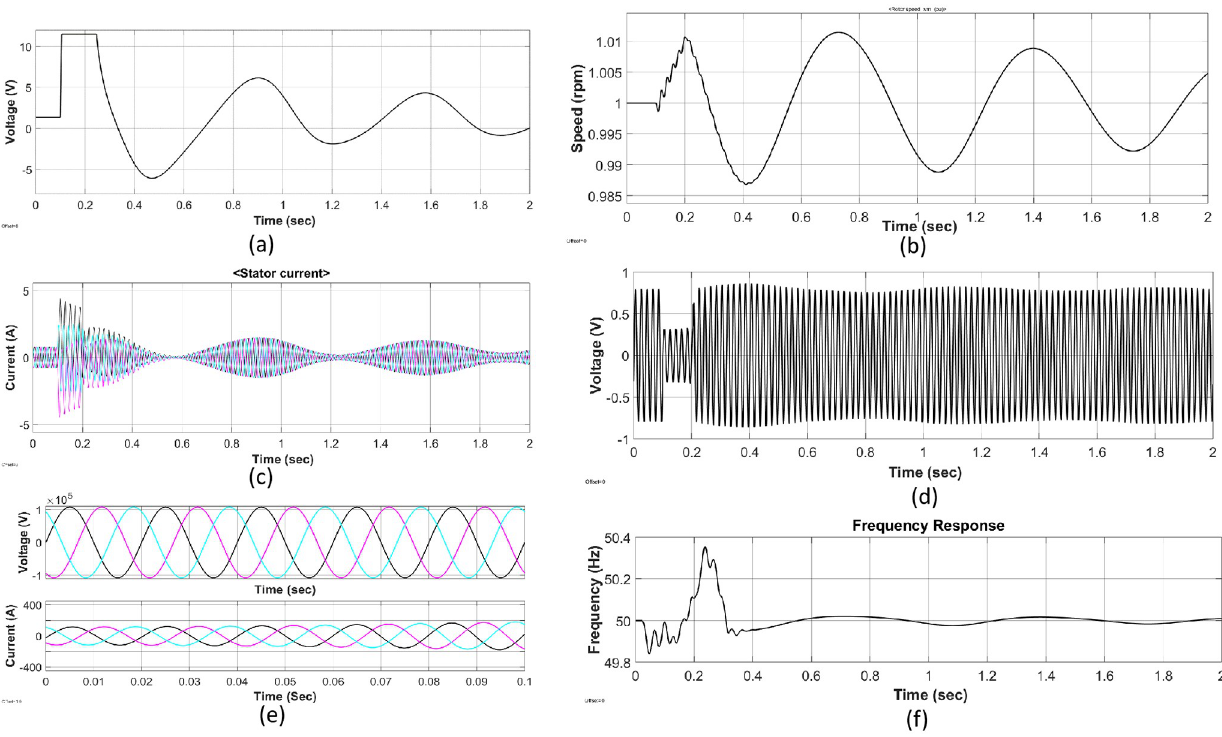
Fig 6. Outputs of the simulation results of unit-4: (a) waveform of excitation voltage, (b) speed of the rotor, (c) stator current, (d) generated voltage, (e) 3-phase voltage and current at load side and (f) overall frequency response.